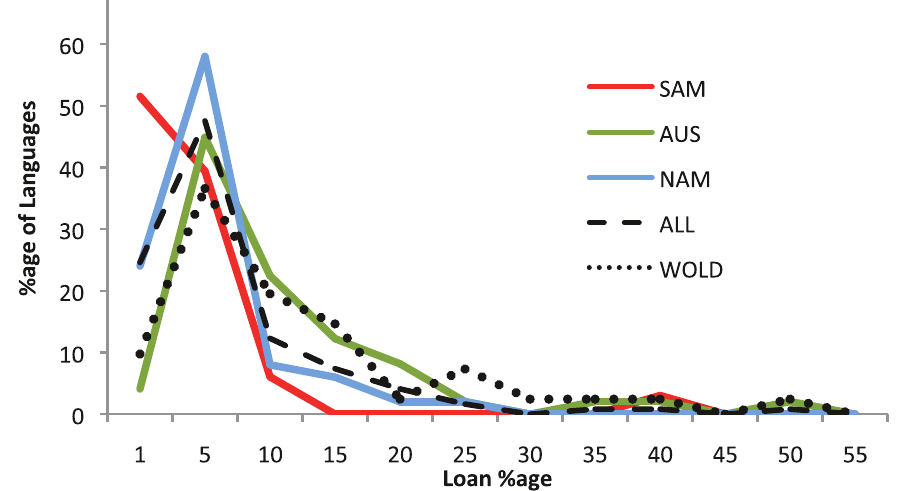
Figure 3. Loan levels across the regions. Line plot of loan levels in Australia (AUS), North America (NAM) and South America (SAM) compared to the aggregate sample (ALL) and the languages from Haspelmath and Tadmor (2009) [1], showing an overall similarity in the distribution of loan levels by language across regions and sample type.